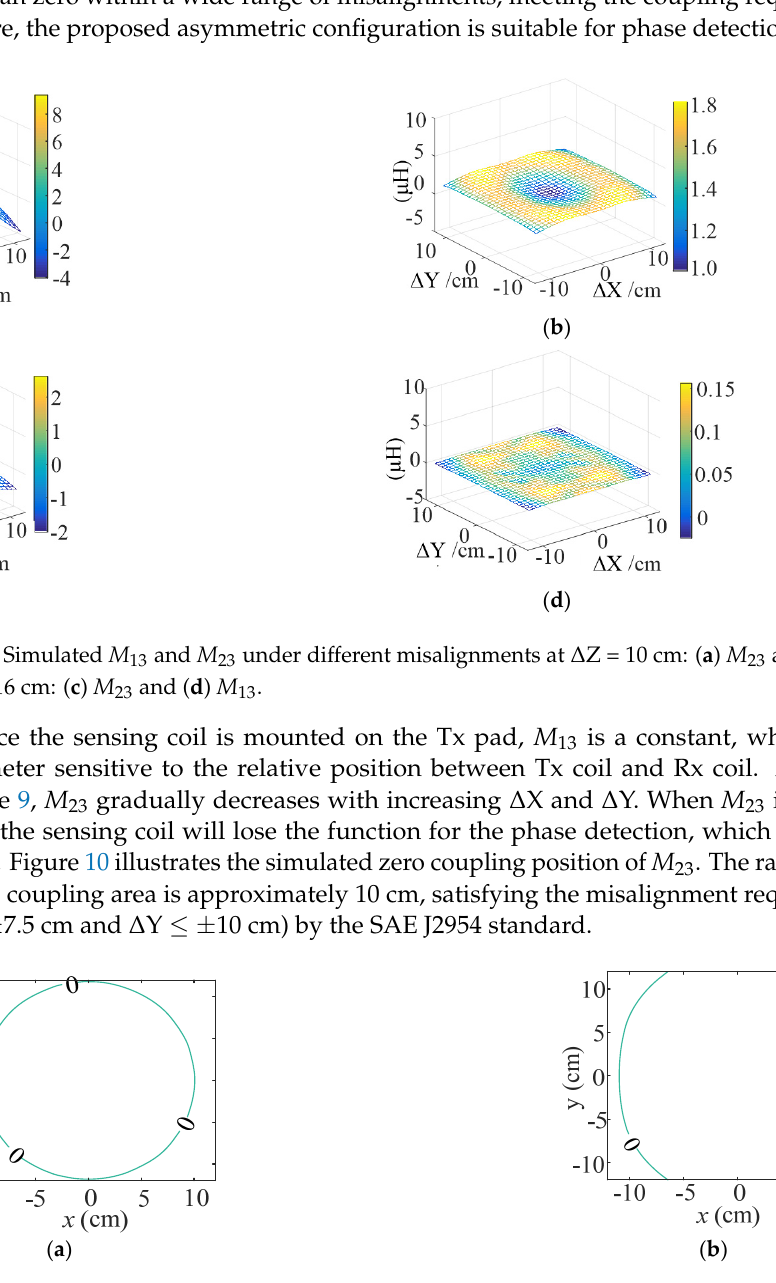
Figure 10. Zero coupling position of M 23 at a clearance of ( a ) ∆ Z = 10 cm and ( b ) ∆ Z = 16 cm.